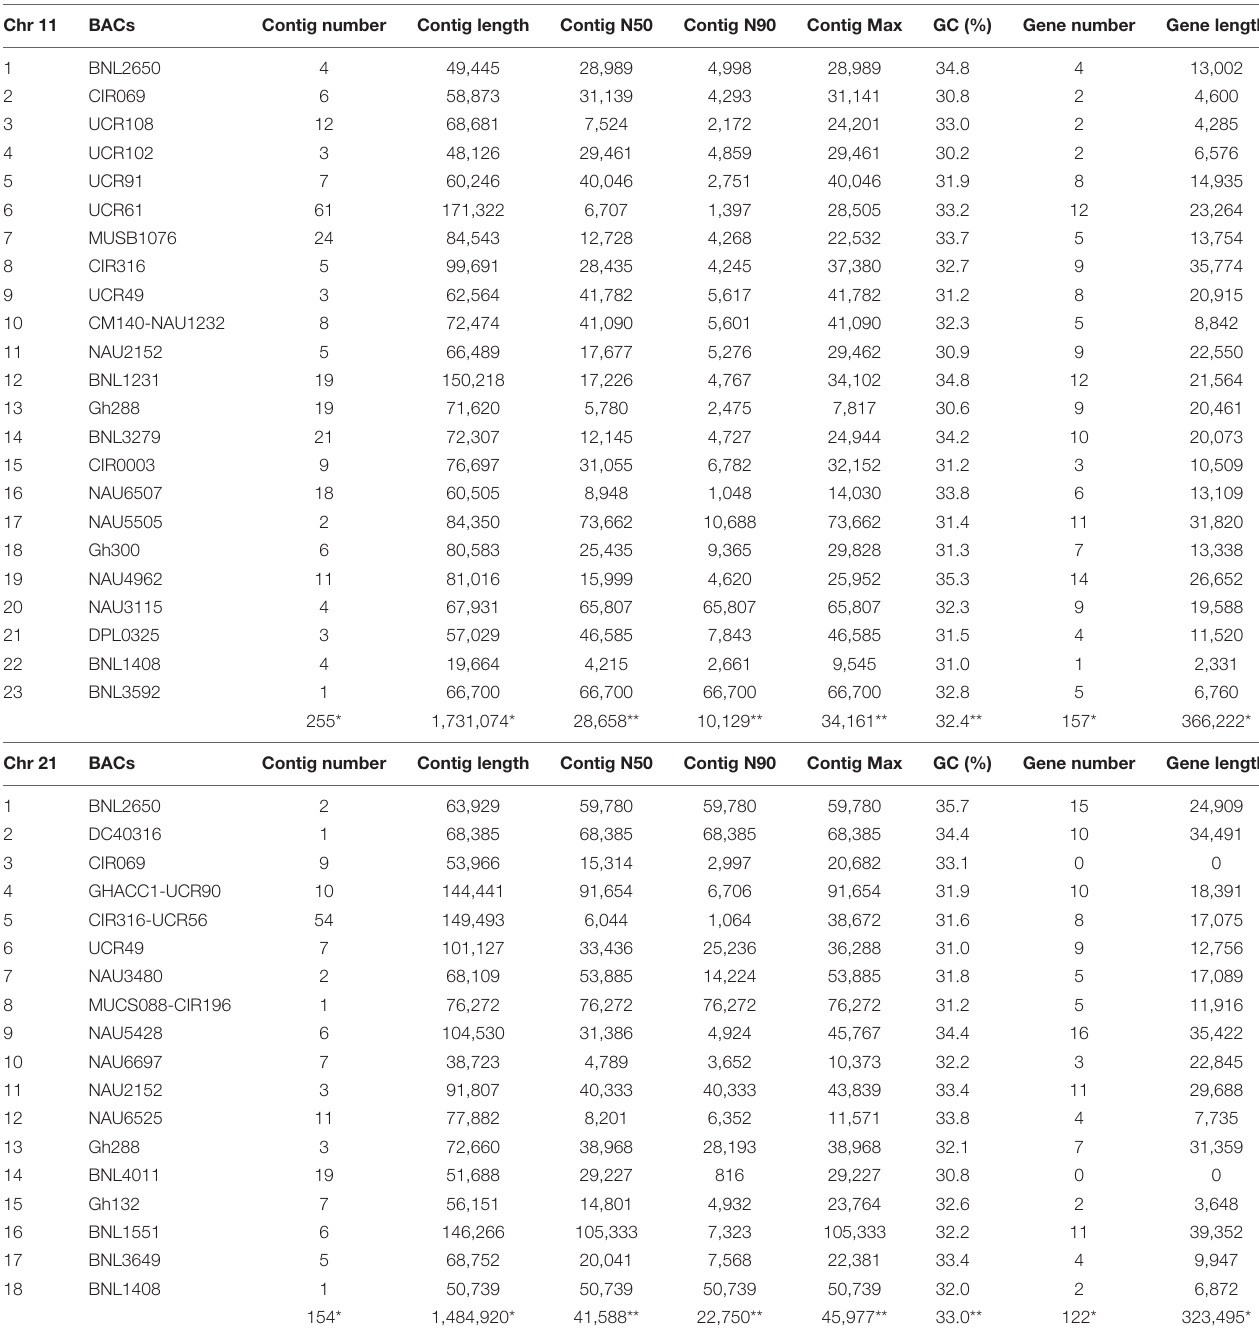
TABLE 1 | The statistical filtered data and identified gene information for the assembled BACs on Chr 11 and Chr